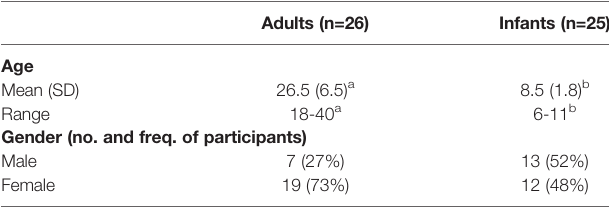
TABLE 1 | Demographic characteristics of study